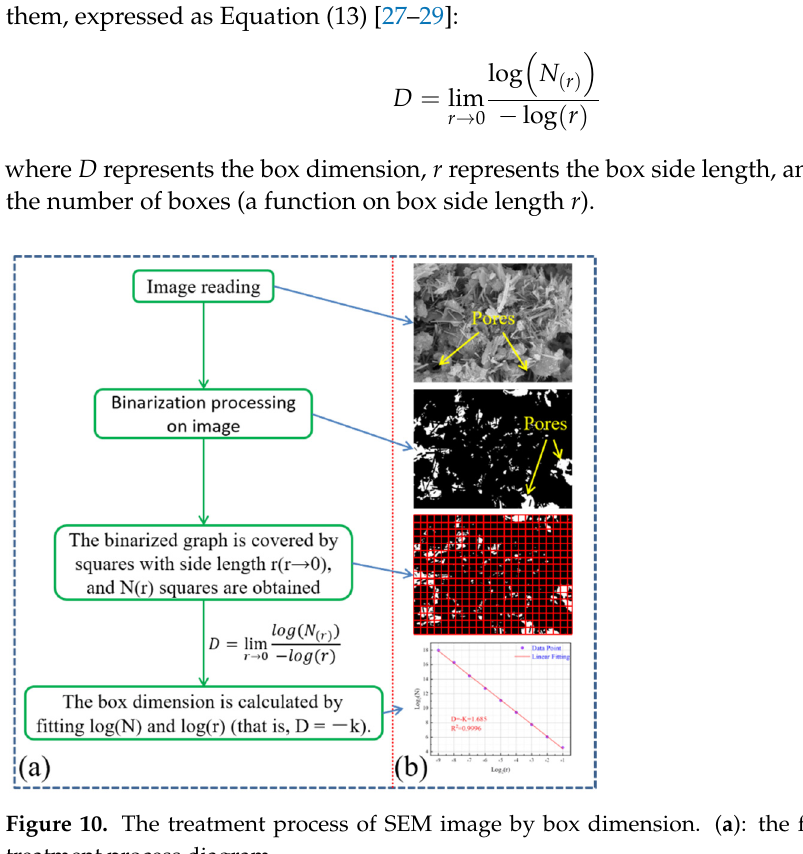
Figure 9. Fractal dimension distribution of pores.